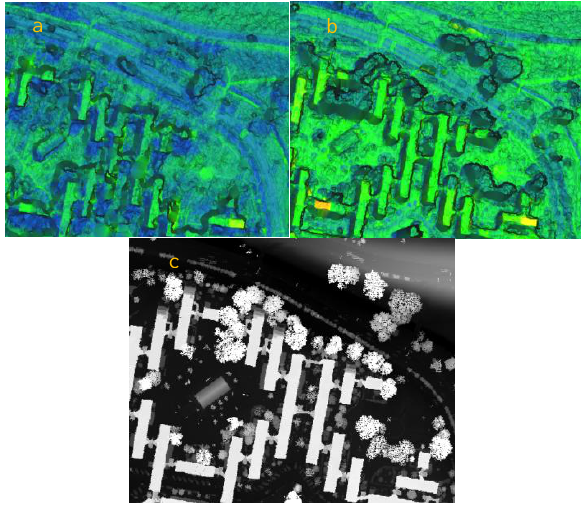
Figure 5. Area with tall trees in: a. Point cloud of winter